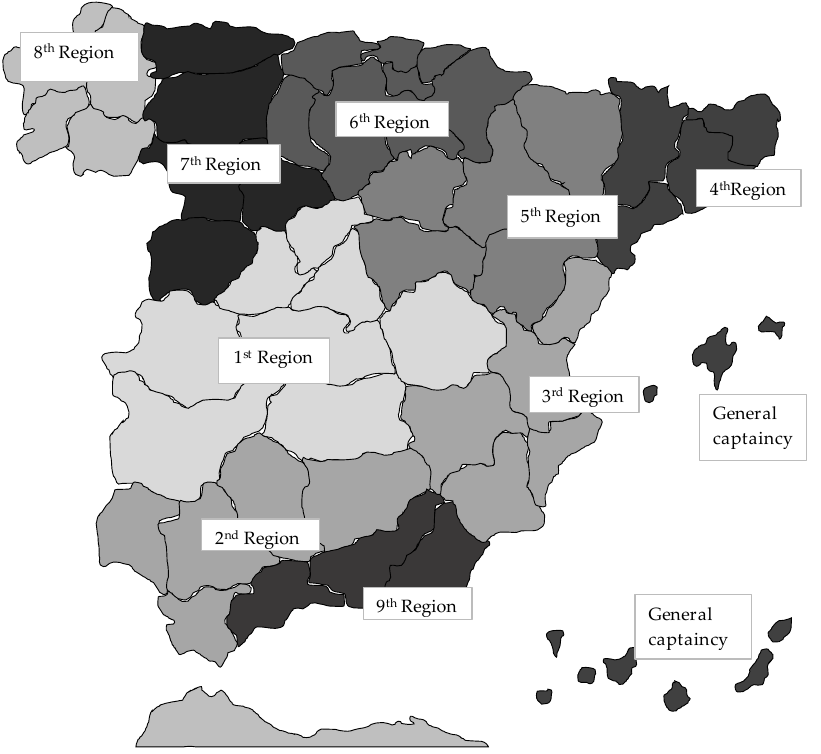
Figure 3. Military regions in Spain (1958). (Army).